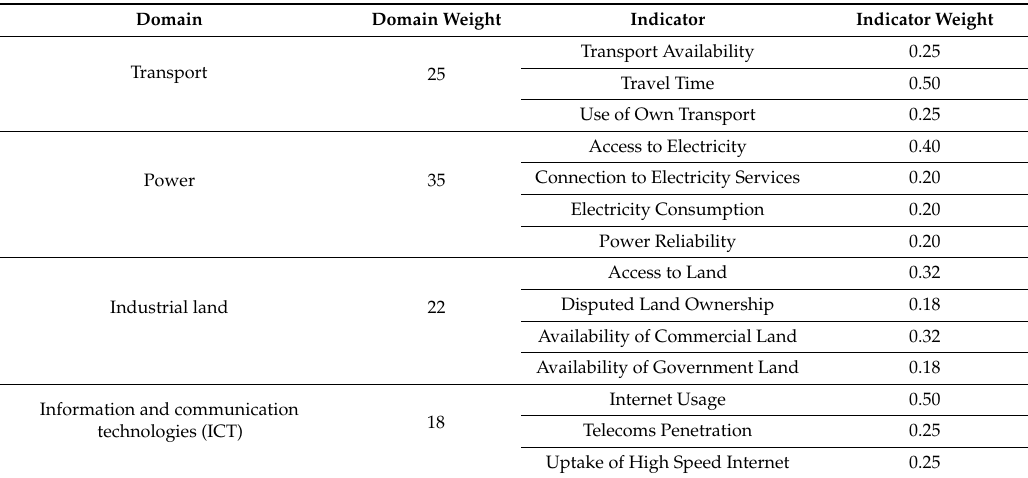
Table 10. Weights Used to Construct the